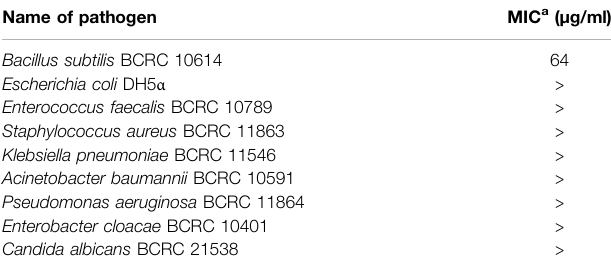
TABLE 1 | Pagoamide A (1) was tested against a number of common